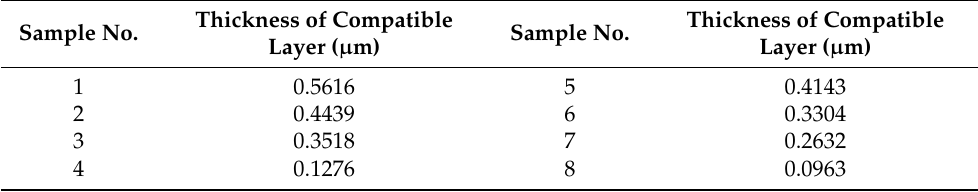
Table 4. Compatibility layer thickness of samples 1–8.